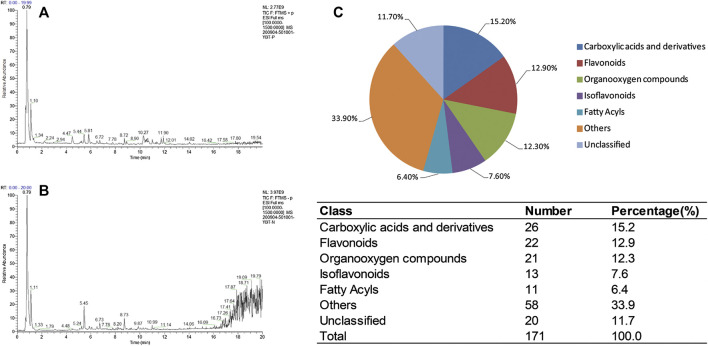
UHPLC-MS/MS of Yiqi-Bushen-Tiaozhi extract solution. (A). Total ion current (TIC) chromatograms in positive mode. (B). TIC chromatograms in negative mode. (C). Classification of the bioactive compounds. The pie graph depicts the percentage of each classification and the number of bioactive compounds in each was shown at the bottom.